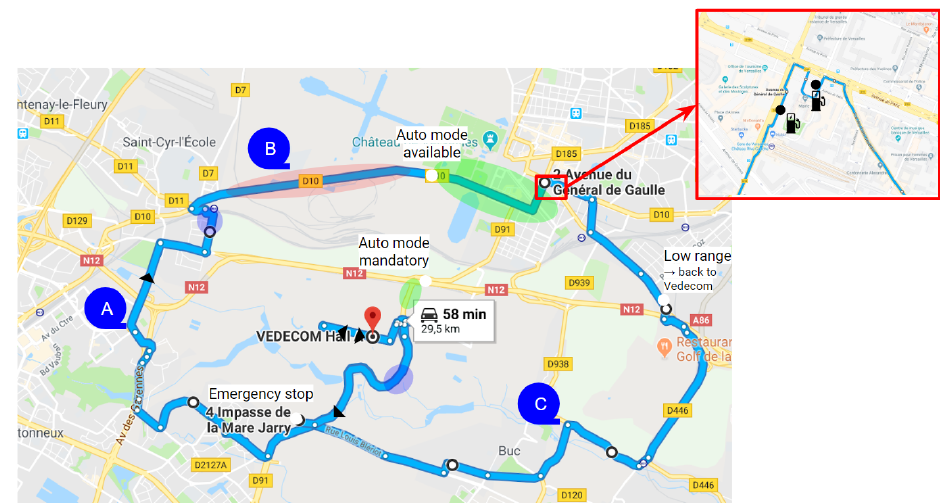
Figure 2. Navigation view of driving session. The whole session lasted 58 min for 29.5 km. Vedecom Hall A was the staring point; driver passed sequentially from points A, B, and C before the emergency